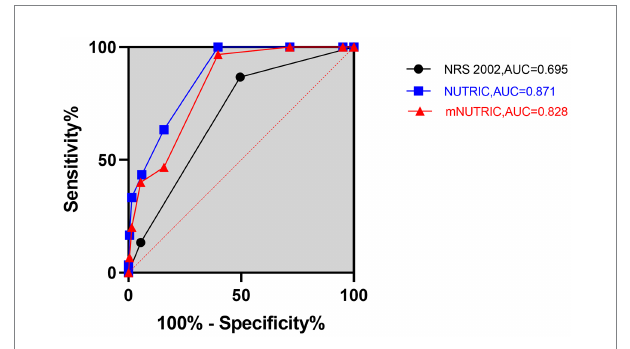
FIGURE 2 Prognostic accuracy of the NRS 2002, NUTRIC, and mNUTRIC to predict 90-day mortality analyzed by receiver operating characteristic curves. The black line with cycle represents the results of the NRS 2002 (AUC = 0.695, 95% CI: 0.604–0.787, p = 0.001). The blue line with square represents the results of the NUTRIC (AUC = 0.871, 95% CI: 0.818–0.925, p < 0.001). The red line with triangle represents the results of the mNUTRIC (AUC = 0.828, 95% CI: 0.754–0.891, p < 0.001).